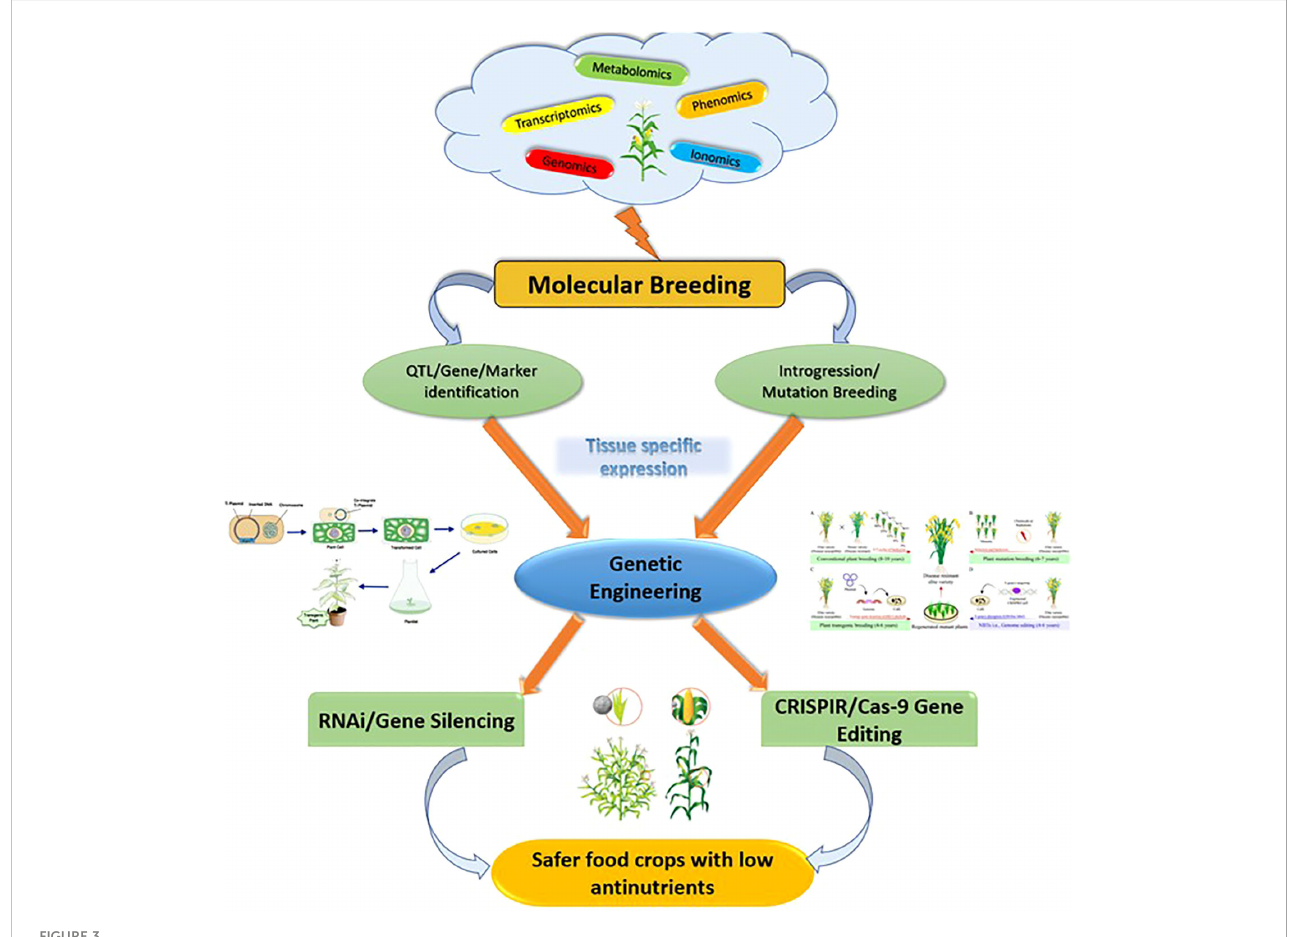
FIGURE 3 Future prospects of improving the quality of food